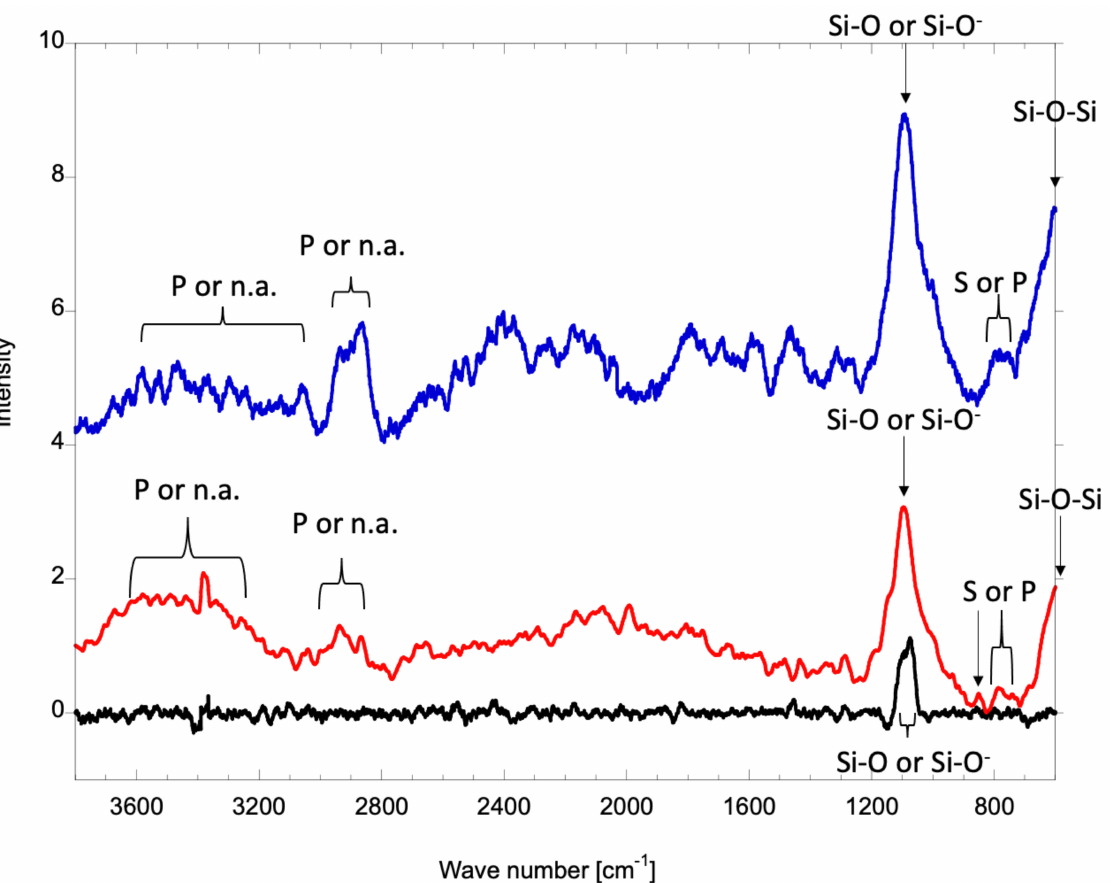
Figure 4. Raman spectra of the surface of soda lime glass. The black, red, and blue lines indicate the Raman spectra for iron piece prior to the tests, after LBR test, and after slowly rotating TTC test, respectively. P: proteins; n.a.: nucleic acids; h.a.: humic-like acids; L: lipids; and S: